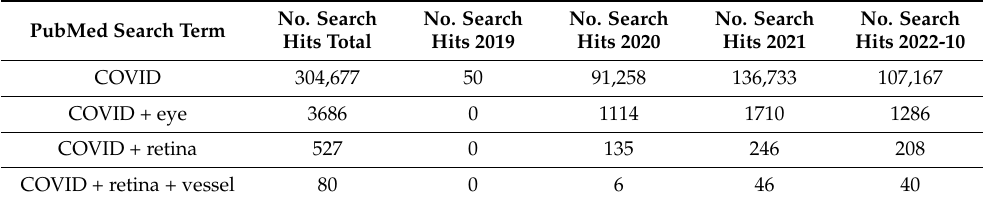
Table 3. Publication database review.